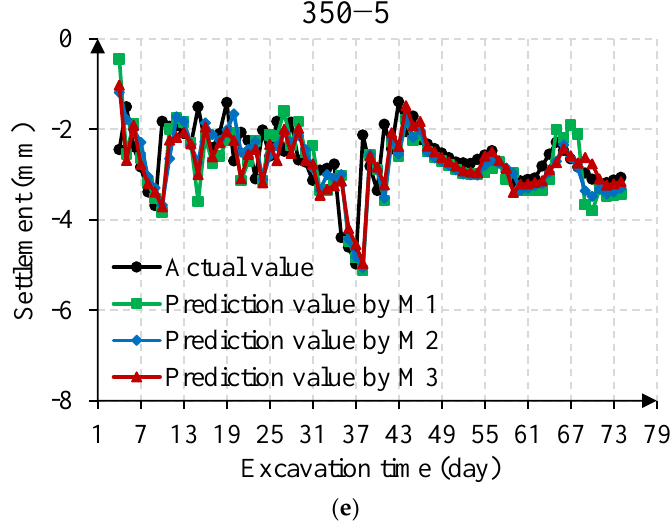
Figure 11. Comparison of prediction results of M1, M2, and M3 at five settlement observation points: ( a ) 350 – 1; ( b ) 350 – 2; ( c ) 350 – 3; ( d ) 350 – 4; ( e ) 350 – 5. Table 4. Average prediction errors of M1, M2, and M3.